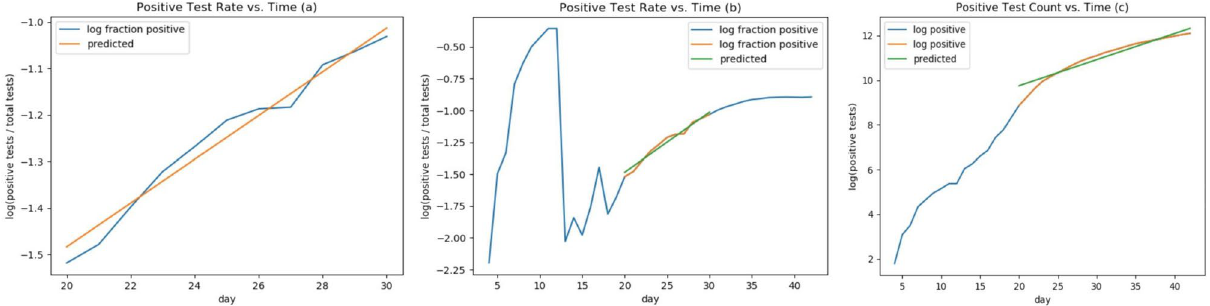
2 Figure 3. Log-linear χ regression estimate of κ from New York State growth of fraction of positive tests. ( a ) Linear regression representing a segment of the positive test rate vs. time; ( b ) linear regression from a) represented within the entire test rate vs. time dataset; ( c ) is a fit to the log of the positive test count vs days starting at 20 days.